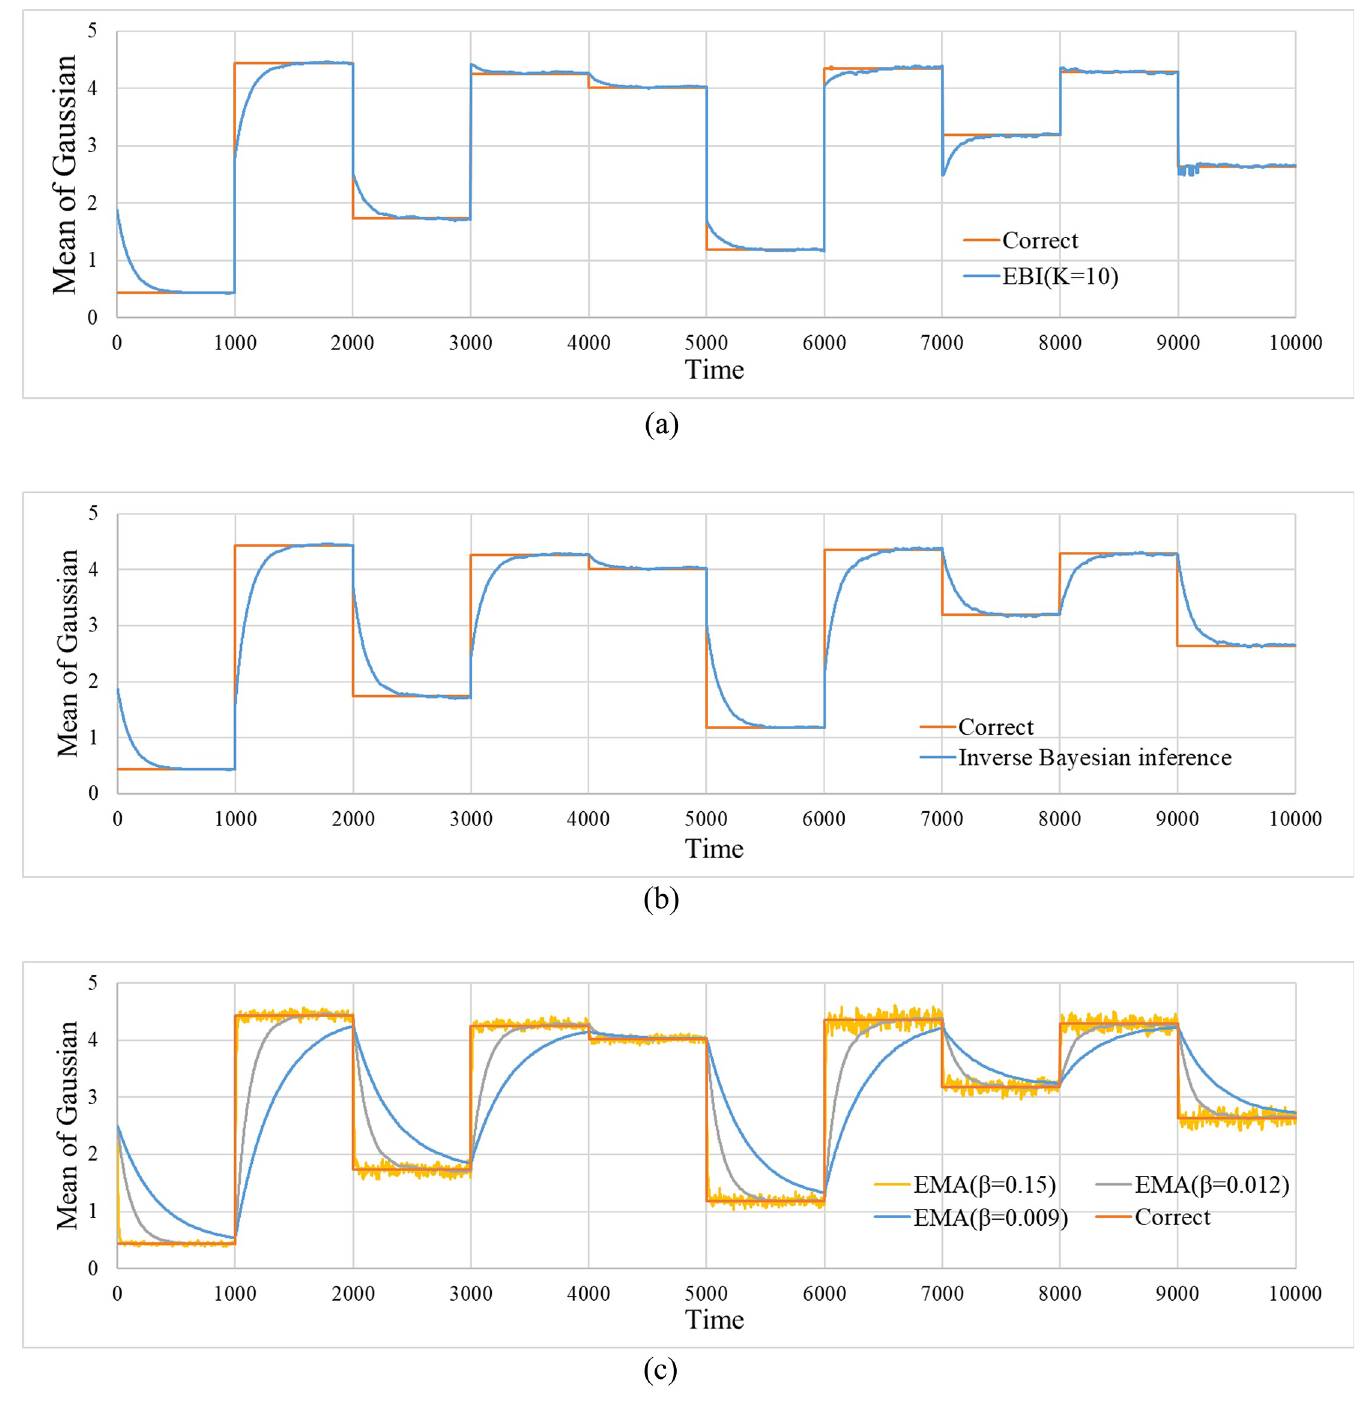
Fig 2. Time progress of the estimated values for the mean of Gaussian. The figures include the correct mean. (a) Estimated values by EBI. ( α , m , K )= (0.018, 0.0, 10). (b) Estimated values by inverse Bayesian inference. ( α , m , K )= (0.018, 0.0, 1). (c) Estimated values by EMA. β = 0.009, 0.012, 0.15.